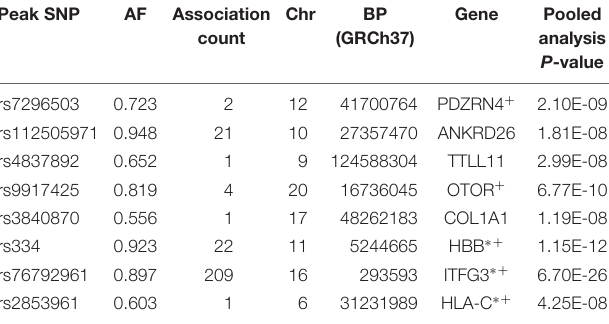
TABLE 4 | Genome-wide significant loci using PC-GWAS